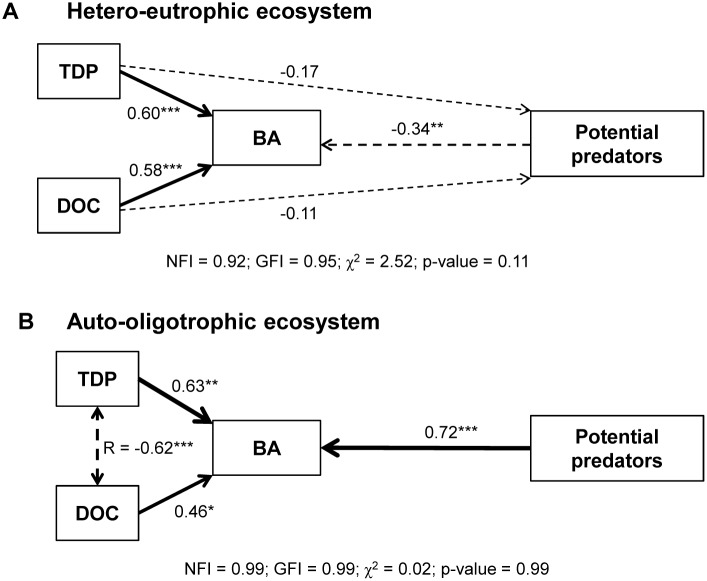
Path diagram representing the relationships between the dynamics of resources, bacterial abundance, and potential predators (mixotrophs and ciliates) for each ecosystem.One-headed arrows depict causal relationships whereas two-headed arrows depict correlations. Positive effects are indicated by solid lines and negative effects by dashed lines. Arrow widths are proportional to path coefficients. Numbers near the paths indicate standardized path coefficients. Significance path p-values are denoted with *p-value<0.05, **p-value<0.01, ***p-value<0.001, while non-significant paths are denoted with the superscript ‘n.s.’. Fit statistics (Goodness of fit index, GFI; normal fit index, NGI; χ2; p-value).